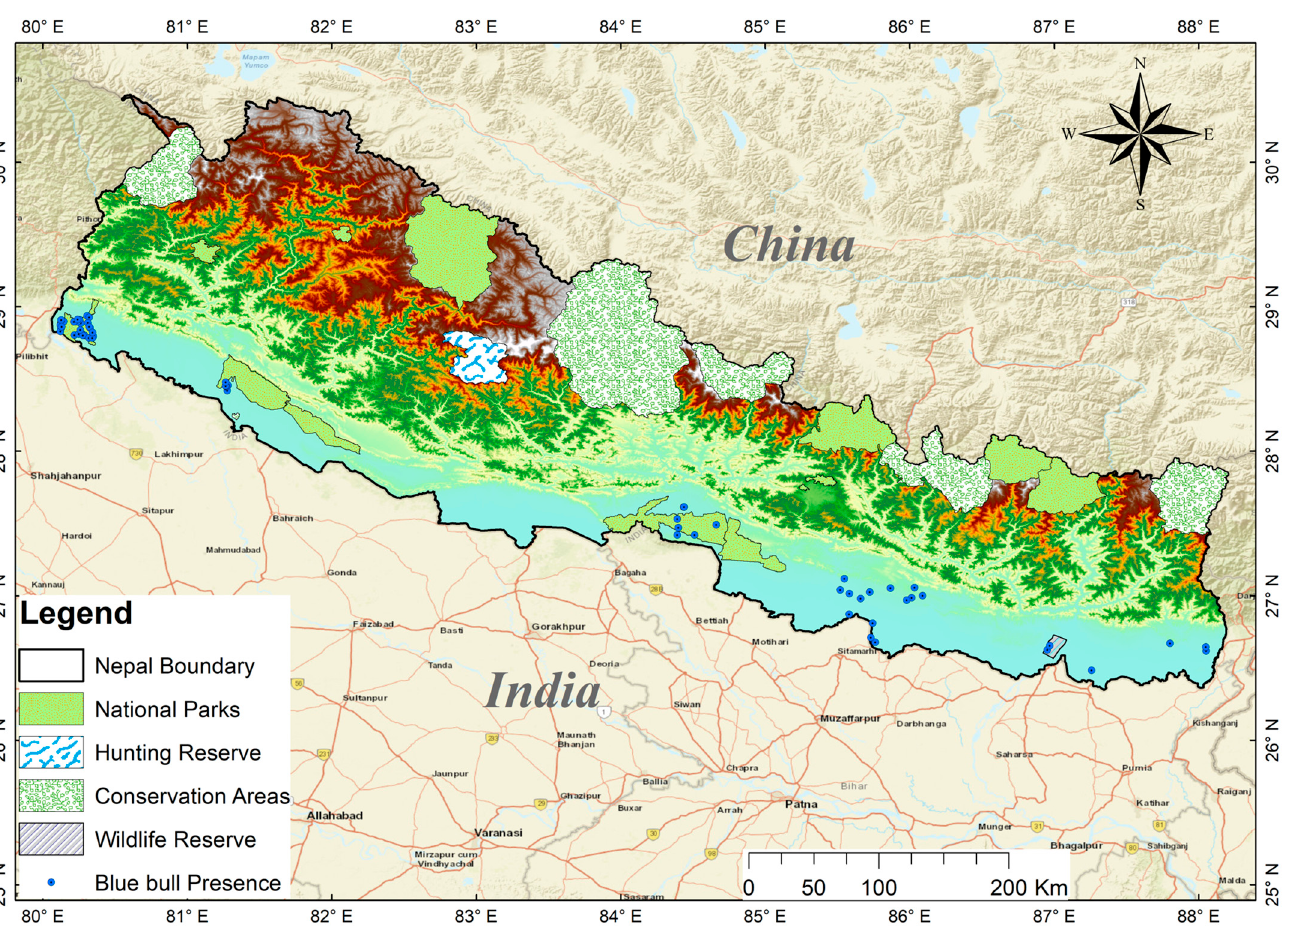
Figure 1. Map of Nepal showing the location of the protected areas of different categories. The blue dots show the current distribution locations of the Blue bull across Nepal.